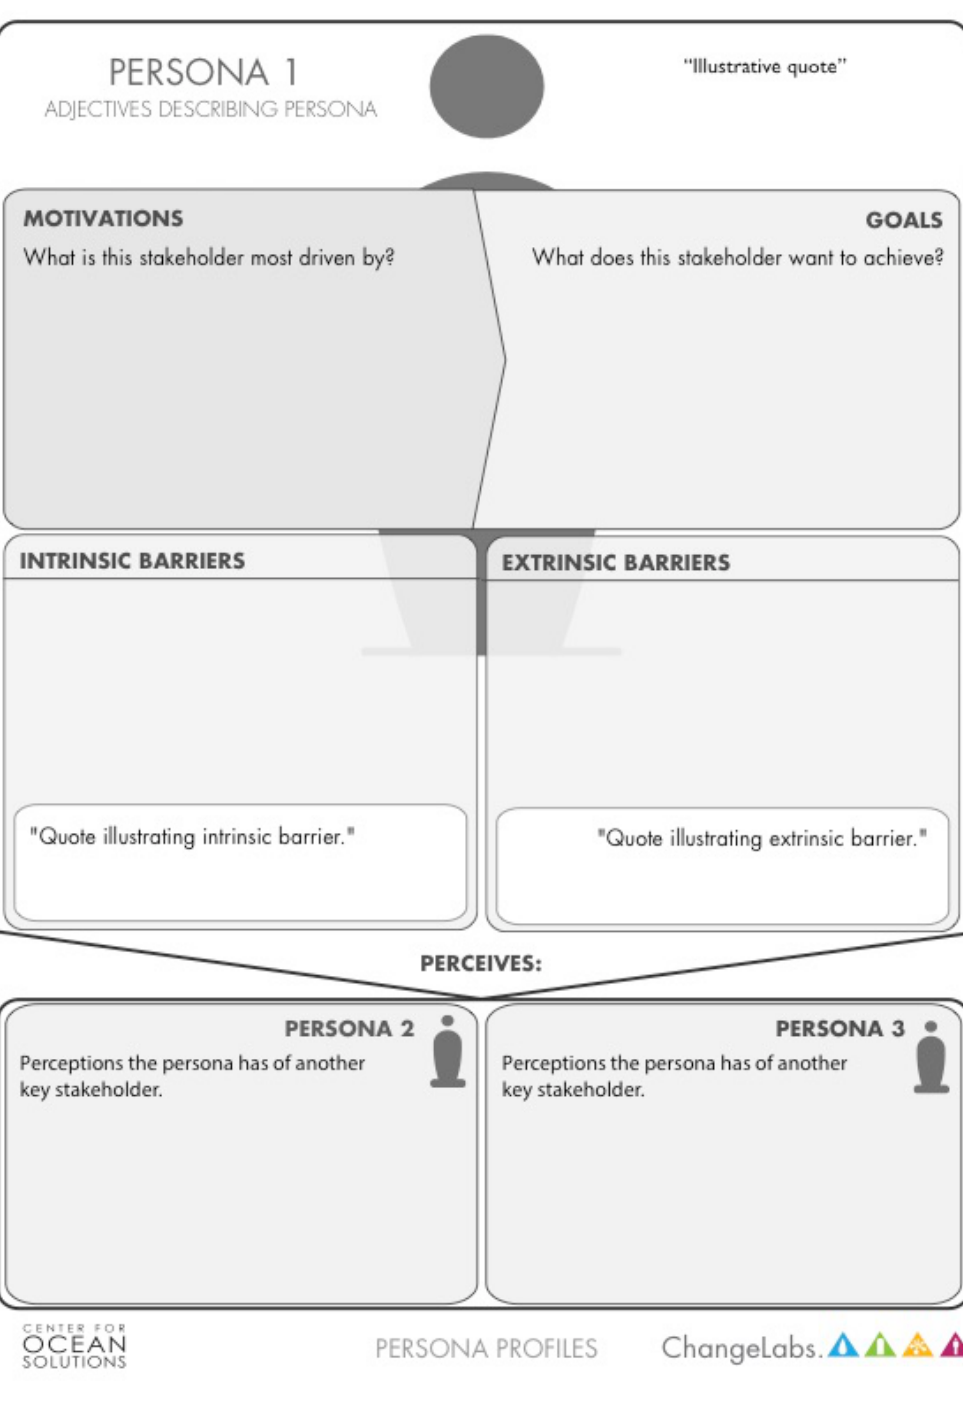
Figure A1.1: Persona profile template used to distill key insights about our four primary stakeholders